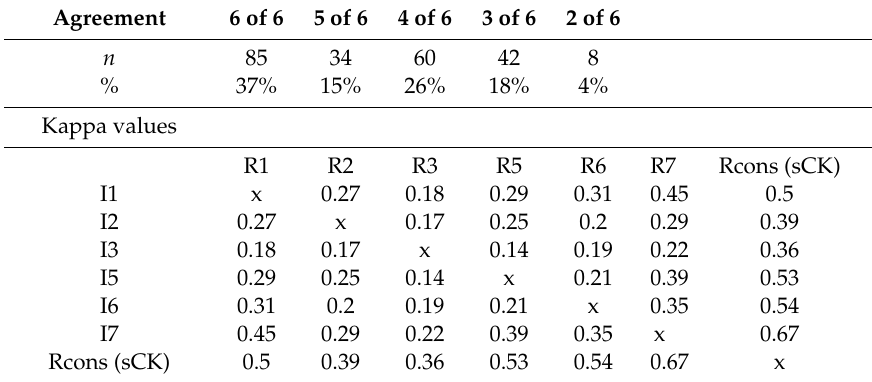
Table 1. Agreements among the investigators and kappa values for paired comparisons among the investigators and the consensus rating, Rcons